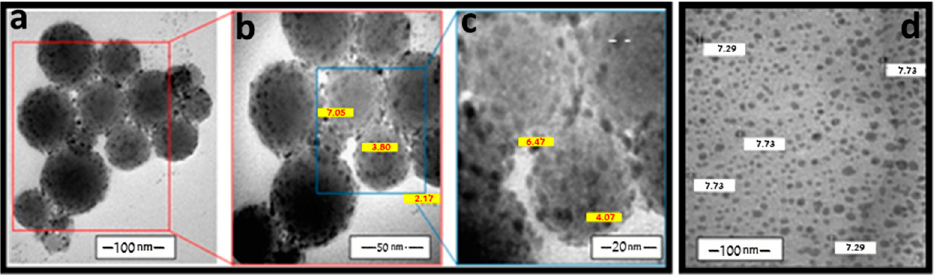
Figure 4. TEM images of nano nickel complex ( a – c ) and copper complex ( d ) in the presence of CTAB (10 − 2 M). (10 − 2 M).